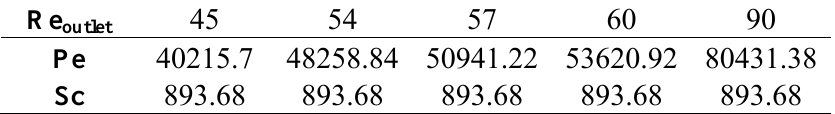
Table 1. Variations of Peclet number (Pe) and Schmidt number (Sc) versus Reynolds